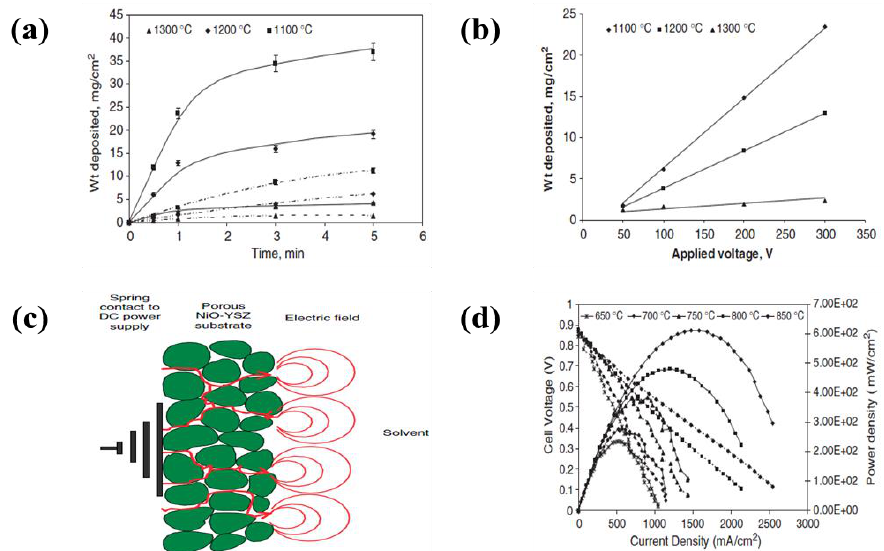
Figure 27. ( a ) Deposition characteristics of yttria-stabilized zirconia (YSZ) on porous NiO–YSZ as a function of the deposition time for a constant applied voltage of 300 V (solid lines) and 50 V (dashed lines); ( b ) Amount of yttria-stabilized zirconia (YSZ) deposited after 1 min as a function of the applied potential on NiO–YSZ substrates sintered at different temperatures; ( c ) Conceptual representation of the possible electrophoretic deposition mechanism on non-conducting substrates; ( d ) Performance characteristics of a solid oxide fuel cell with the configuration, NiO–YSZ/YSZ/LSM–YSZ, as a function of the operating current density.